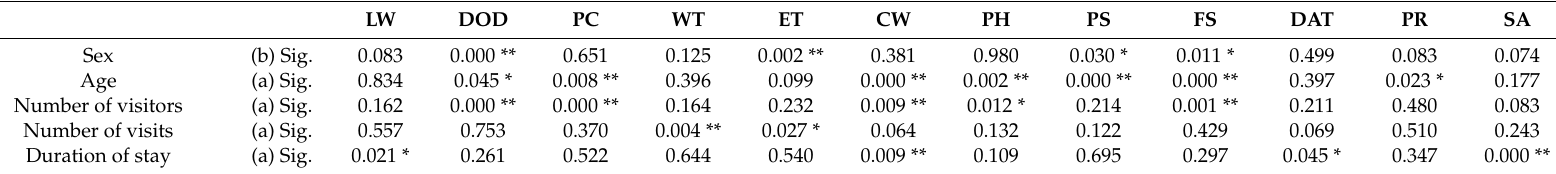
Table 2. Di ff erences in visitor selections for di ff erent visitor